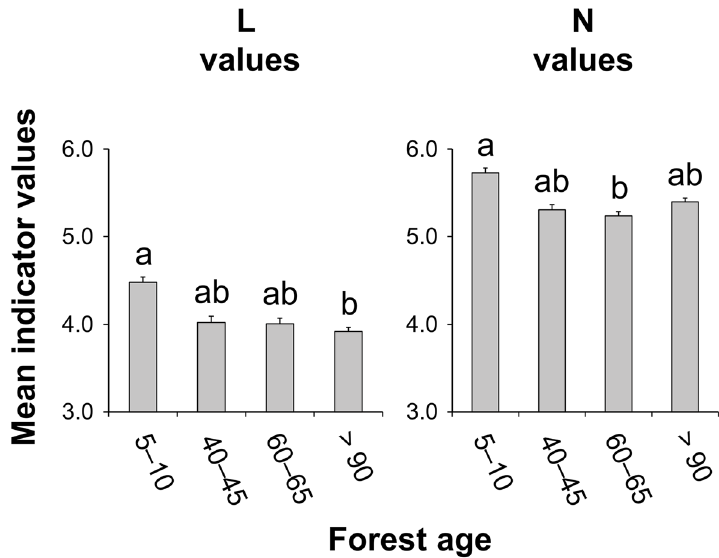
Fig. 8 Mean Ellenberg indicator values (L: light availability, and N: nutrient availability) in the plots of dolines covered with different forest age classes (class 1: 5–10-year-old forest stands with mature forest patches, class 2: 40–45-year-old forests, class 3: 60–65-year-old forests, and class 4: more than 90-year-old forests) (mean SE). Significant differences (p < 0.05, based on the LMMs with Bonferroni post hoc tests) are indicated by different lower ± case (a and b) letters